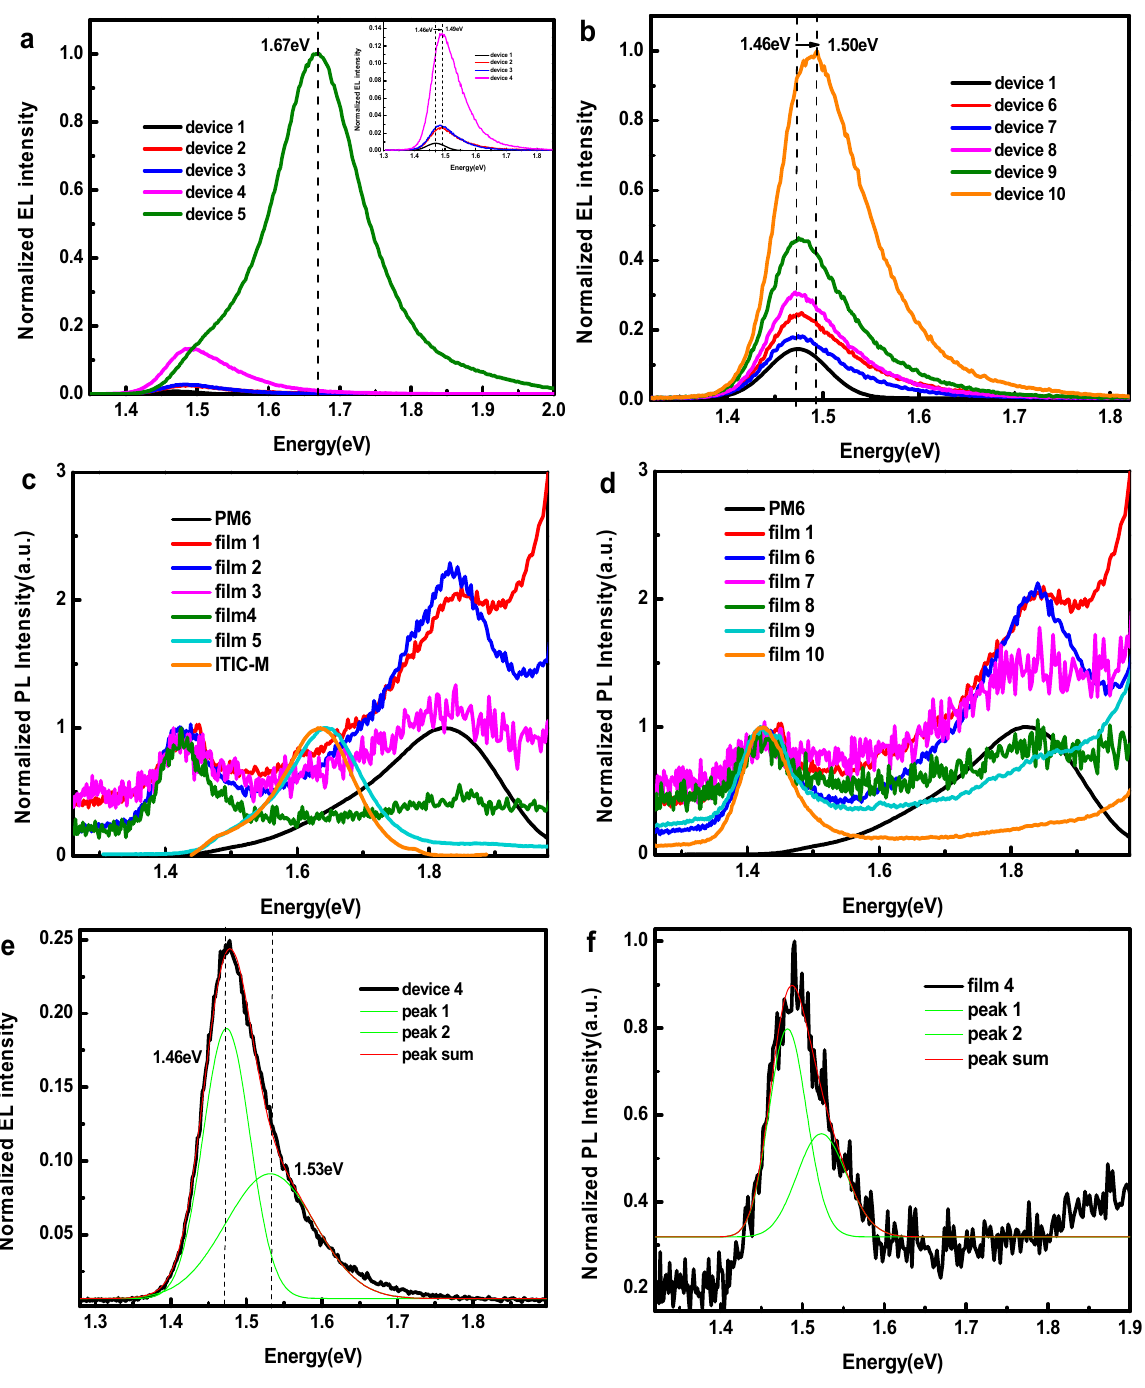
Figure 5. EL spectroscopy of ( a ) devices 1 to 5 (inset image is EL spectroscopy of film 1 to 4), ( b ) devices 1, 6 to 10, PL spectra of ( c ) pure PM6 film, ITIC-M film and films 1 to 5, ( d ) pure PM6 film and films 1, 6 to 10, excited at 550 nm. Multiple peaks, Gaussian fitting of ( e ) EL spectroscopy of device 4 and ( f ) PL spectroscopy of film 4.